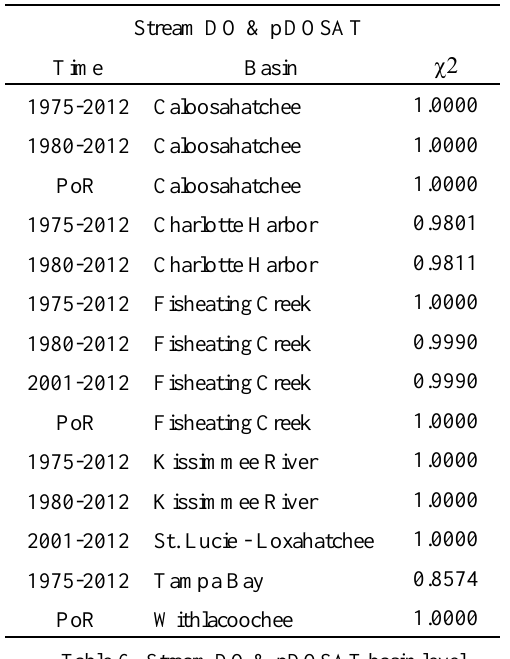
Table 6. Stream DO & pDOSAT basin level analysis. Chi square test for independence was